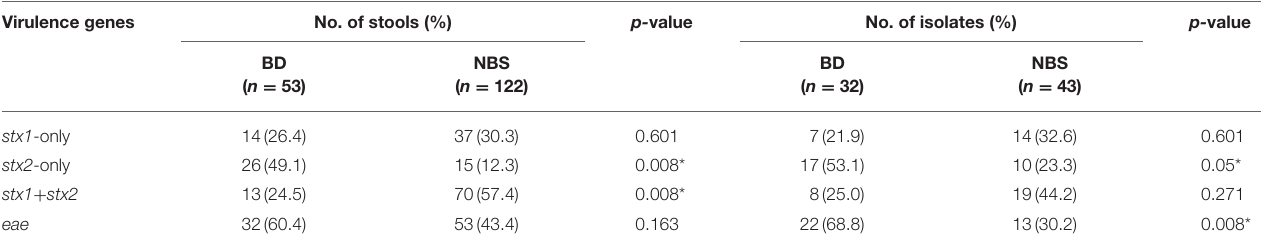
TABLE 2 | Prevalence of stx and eae detected on stools and isolates in correlation with bloody diarrhea (BD) and non-bloody stools (NBS). Virulence genes